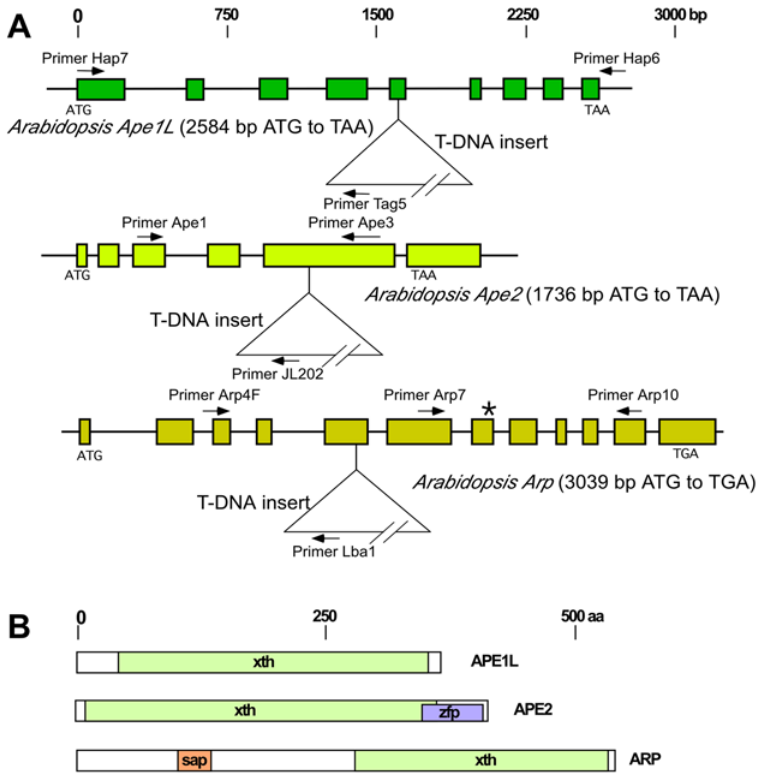
Figure 1. A. Relative sizes and structures of the genes for abasic endonucleases Ape1L , Ape2 , and Arp . Diagrams show intron/exon structures, the positions of primers used to assay the identities of alleles, the locations of T-DNA inserts and, for Arp , the mis-sense mutation (*). For Ape2 , only the predicted coding regions of gene model At4g36050.1 are shown. B. Relative sizes and predicted domains of the APE1L, APE2, and ARP proteins . xth, Xth exodeoxyribonuclease III; sap, DNA binding; zfp, GRF-type zinc-finger